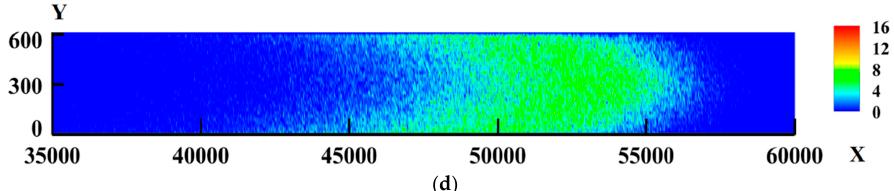
Figure 2. Development of the mixing region with time for two puffs, puff A: Sc = 0.7, y o = 300, and puff B: Sc = 0.7, y o = 75. ( a ) Contours of n AB at t = 500; ( b ) Contours of n AB at t = 1000; ( c ) Contours of n AB at t = 2000; ( d ) Contours of n AB at t = 3000.